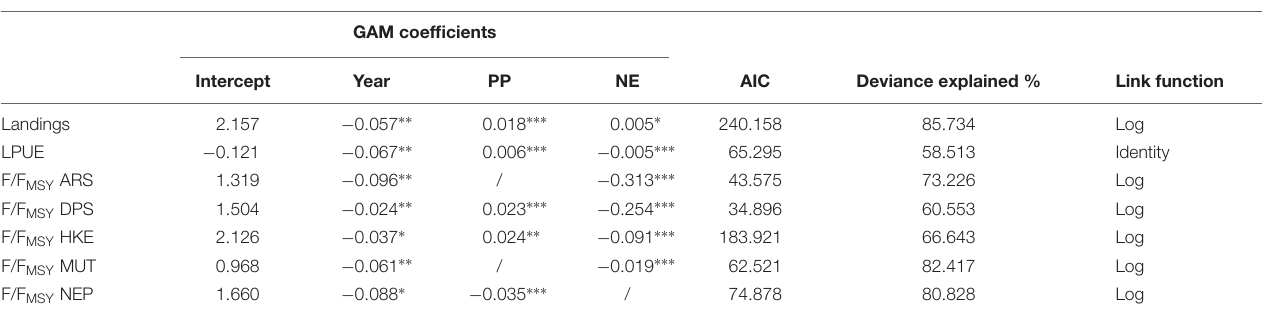
TABLE 3 | Summary of GAM results for the F/F MSY of the five selected